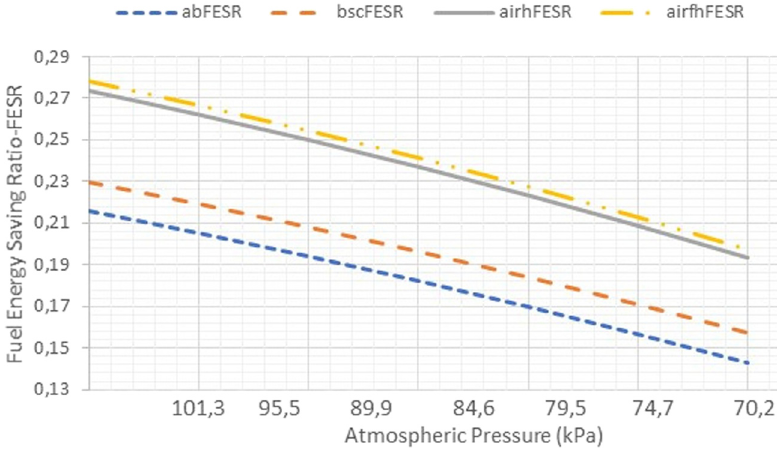
Figure 8: Variation of the FESR with atmospheric pressure for ab, bsc, airh, and airfh cogeneration